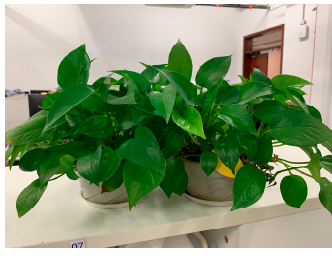
Figure 7. The separation of the pots.